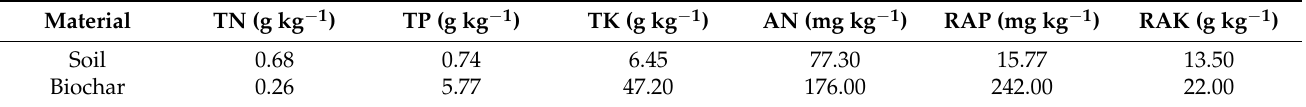
Table 1. Chemical Properties of Soil and